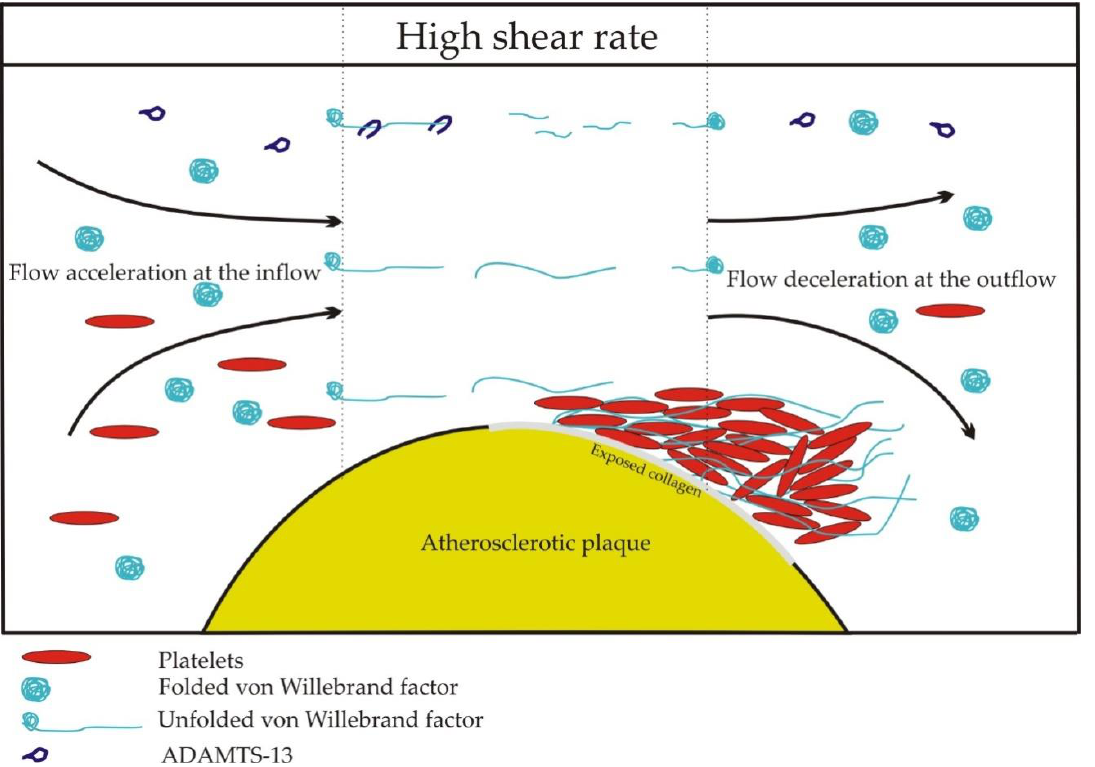
Figure 2. Shear rate-induced activation of the von Willebrand factor at the site of atherosclerotic narrowing of a vessel.